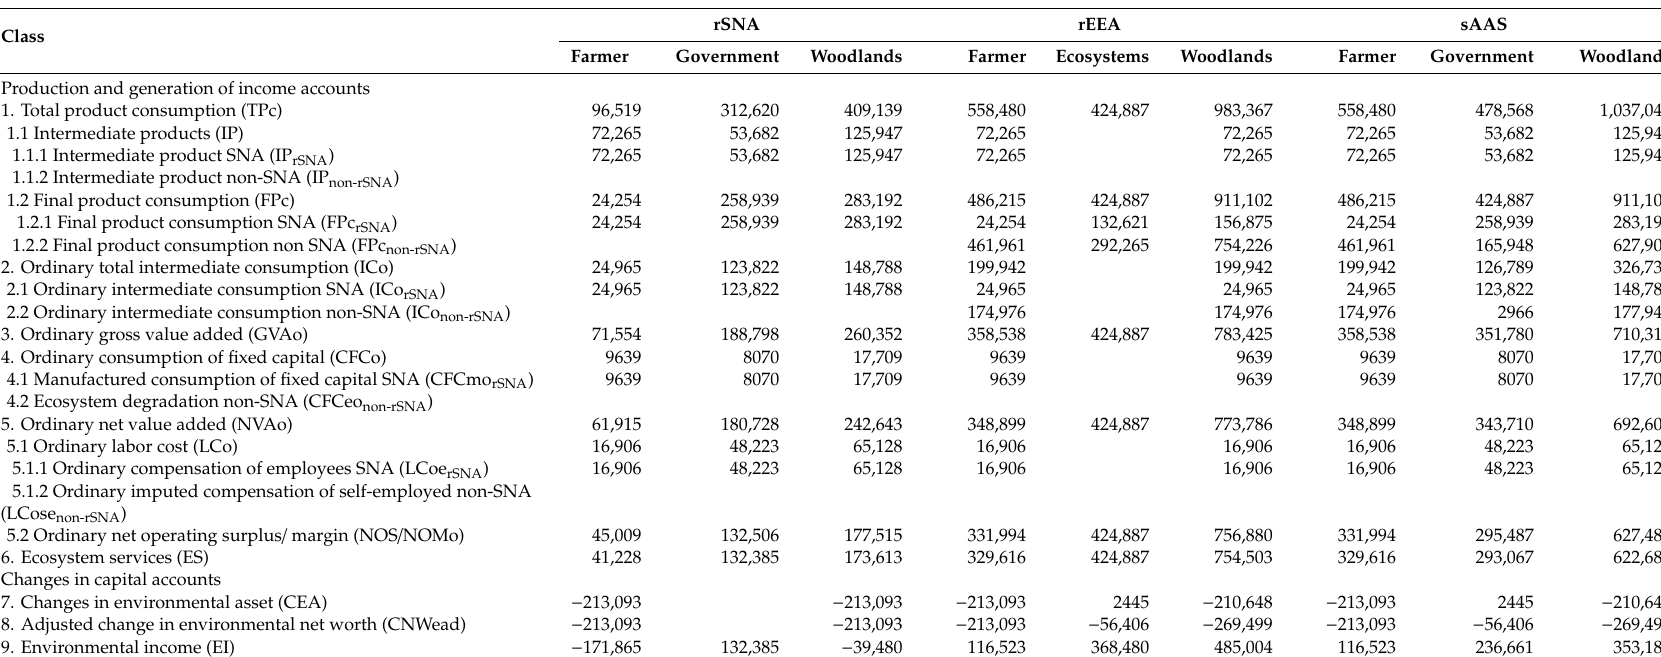
Table 1. Ecosystem accounting: stylized rSNA and rEEA versus sAAS sequence of accounts in holm oak open woodlands in Andalusia, Spain (2010: thousands of